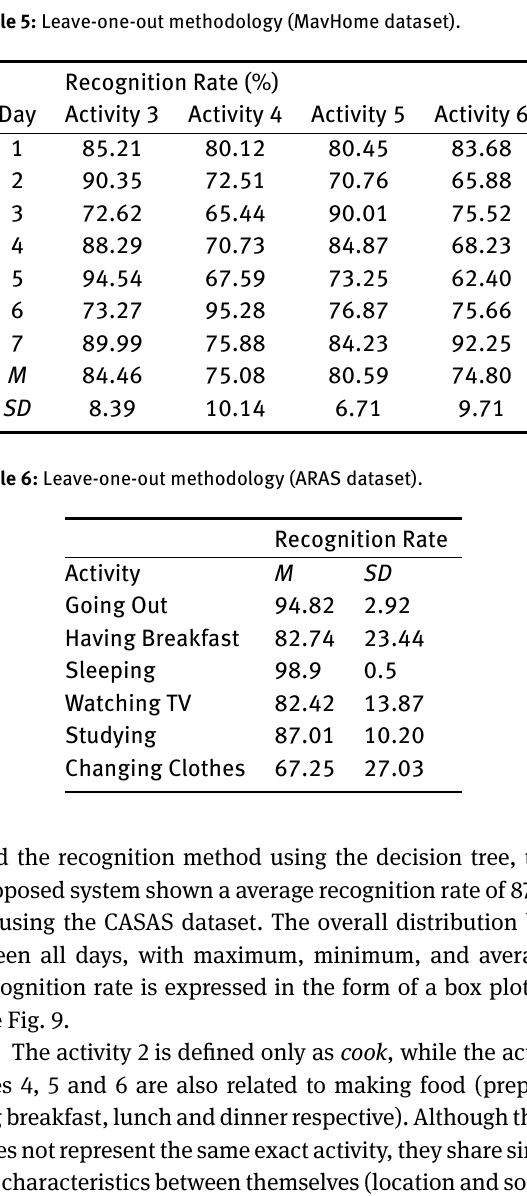
Table 5: Leave-one-out methodology (MavHome dataset).